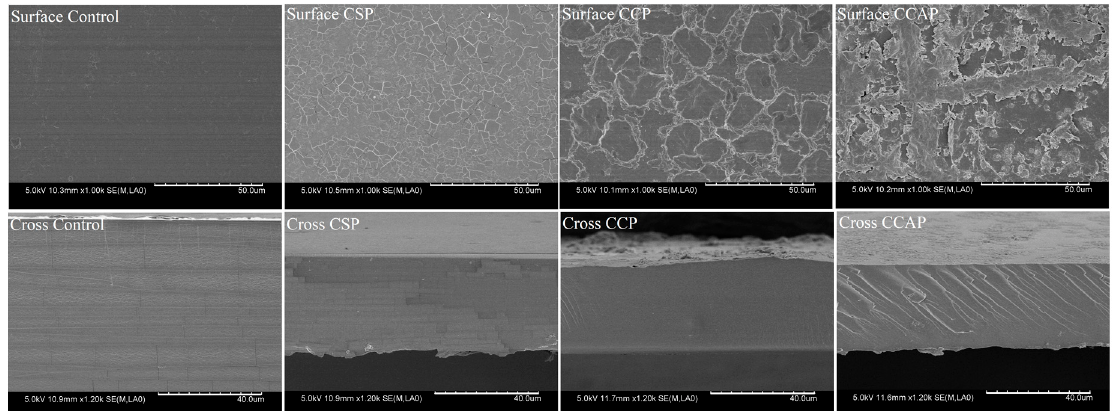
Figure 8. SEM images of the surface and cross-section of chitosan (control) and peptide − containing films. CSP: films from chitosan and soy protein peptides; CCP: films from chitosan and corn protein peptides; CCAP: films from chitosan and casein peptides.